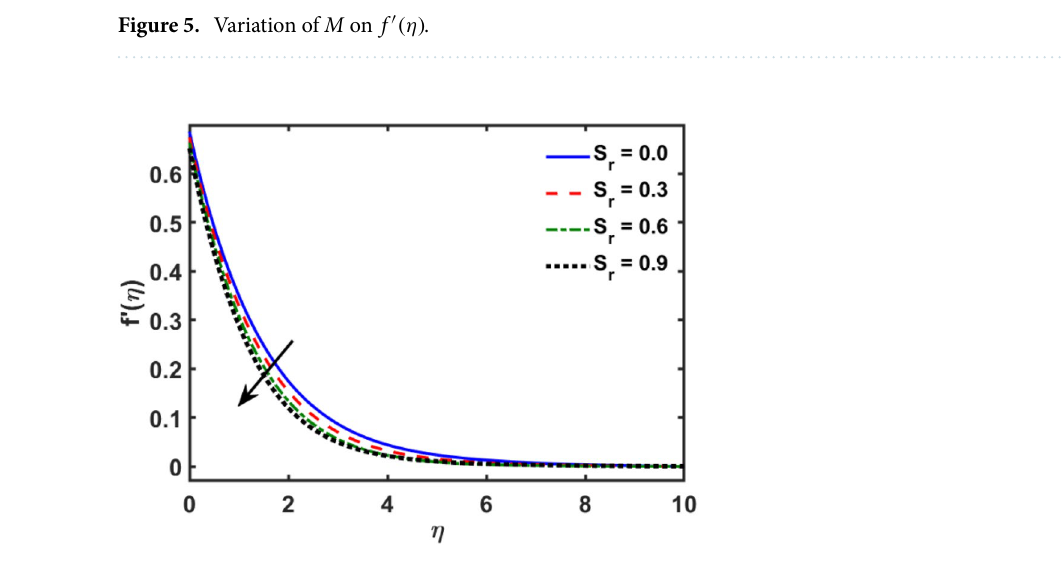
Figure 6. Variation of S r on f ′ (η)